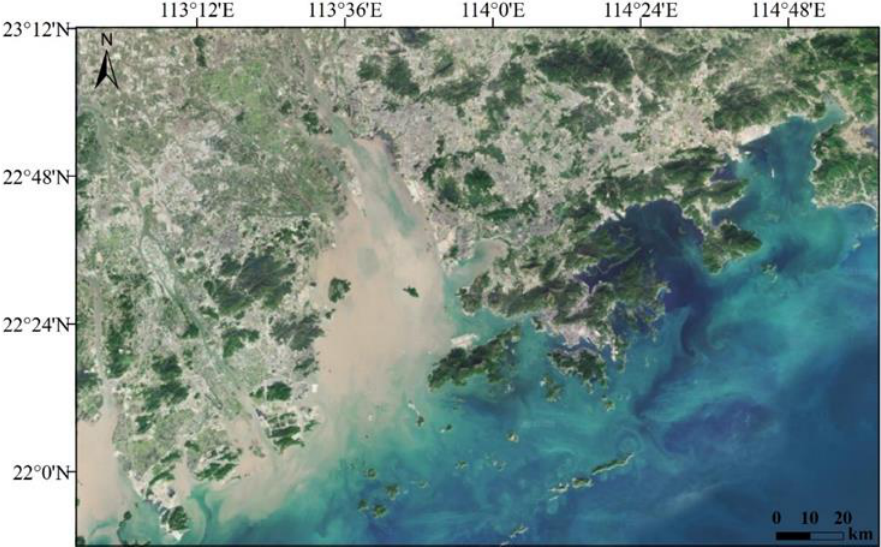
Figure 1. Map of the Pearl River Estuary.